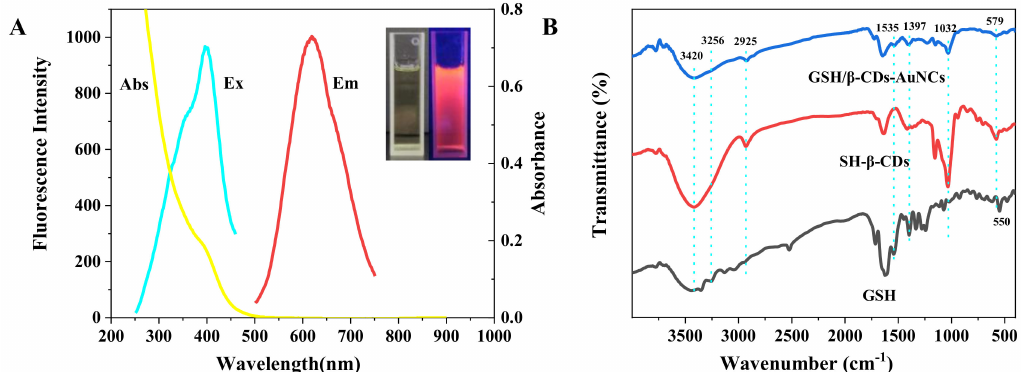
Figure 1. ( A ) Absorbance, excitation, and emission spectra of GSH/ β -CDs-AuNCs. Insert image is GSH/ β -CDs-AuNC solu- tion under daylight (left) and UV light (right). ( B ) FTIR spectra of GSH, SH- β -CDs, and GSH/ β -CDs-AuNCs,